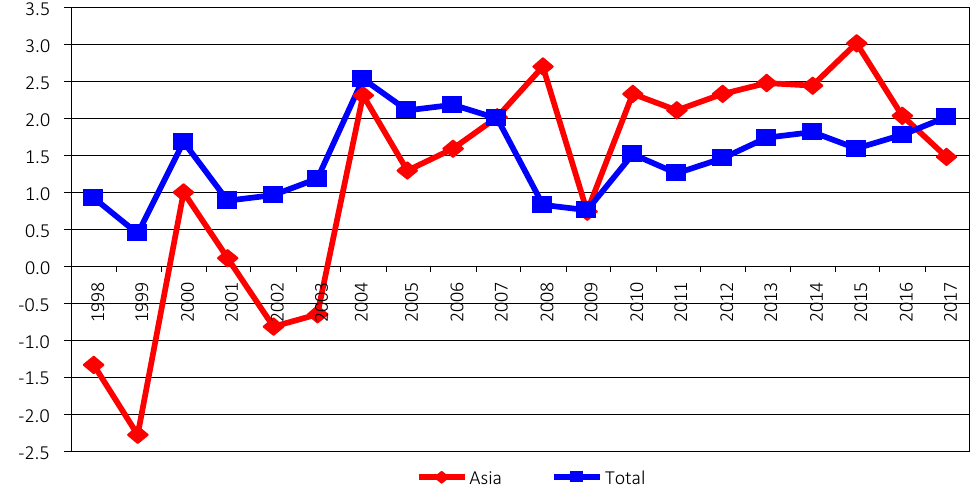
Figure 3. Financial stability index of banking systems of the World and Asia